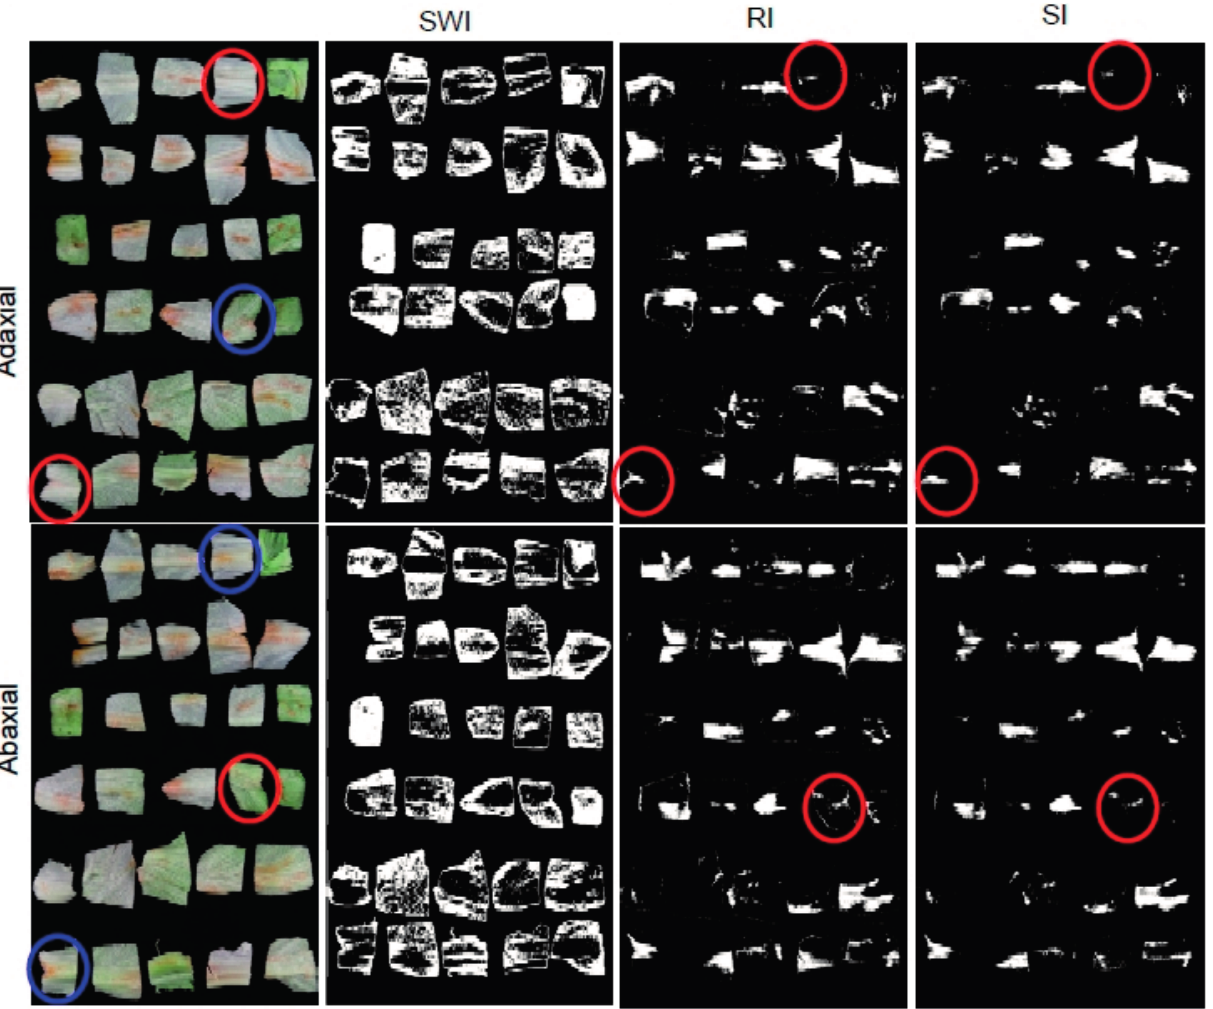
Figure 14. Prediction results for ( a ) an RGB picture of the validation samples; ( b ) SWI algorithm (I 547 ); ( c ) RI algorithm (R 552/701 ); and ( d ) SI algorithm (S 557-701 ) using fresh-cut